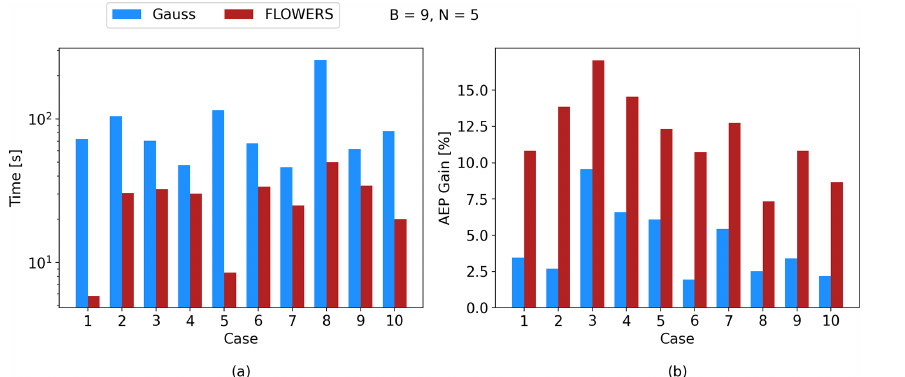
Figure 14. The 10 randomized cases for FLOWERS against the Gauss model with B = 9 wind direction bins. FLOWERS is only about 5 times faster than Gauss now, on average. The average AEP gain for FLOWERS is about 12%, but only about 4.5% for Gauss.